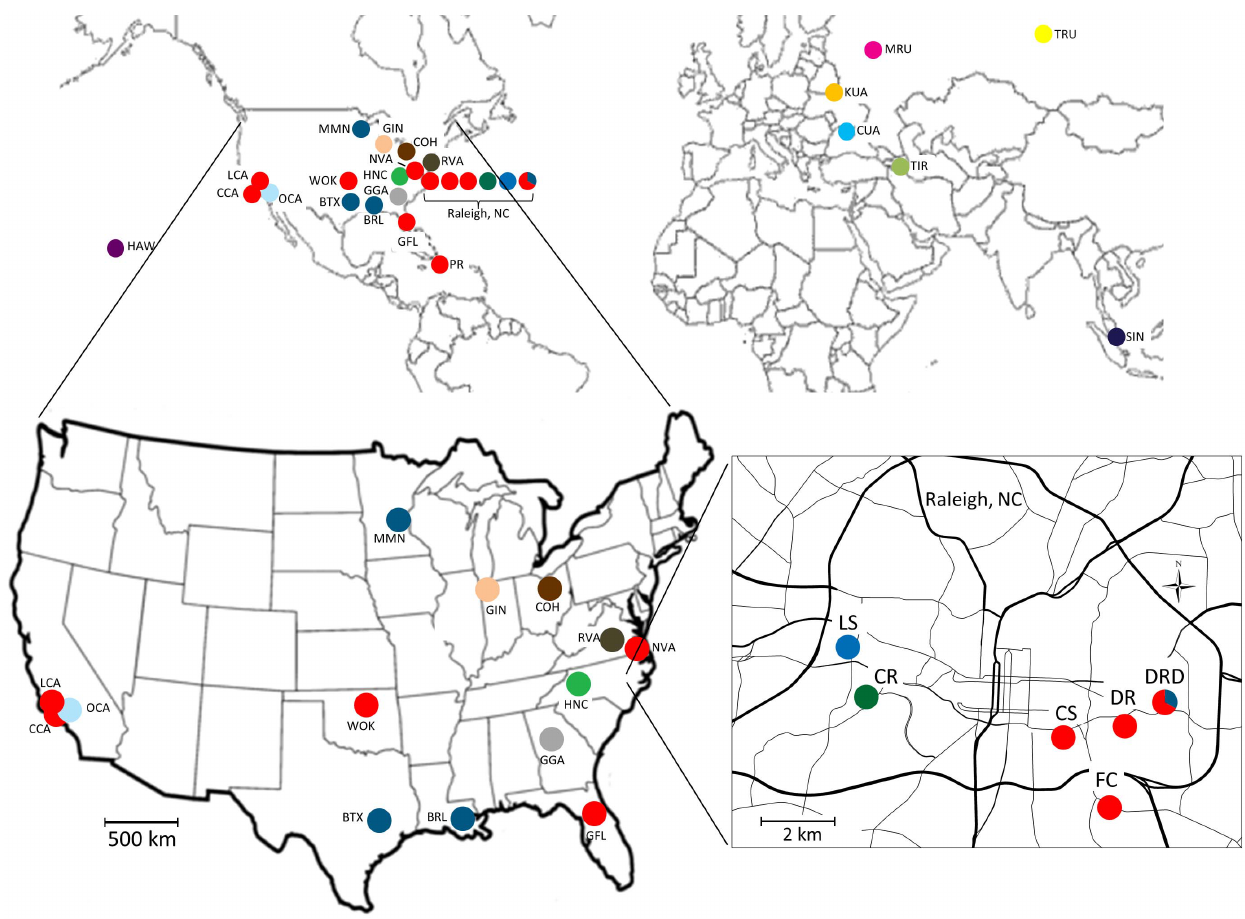
Figure 3. Bayesian cluster analysis of 40 global B.germanica populations as identified by the program BAPS. Populations given the same color were grouped into the same genetic cluster. The analysis identified 17 distinct clusters, 11 for the 36 U.S. populations, whereas each of the six Eurasian populations formed a unique cluster. The 18 Raleigh, North Carolina samples are grouped by apartment complex. In only one case (complex DRD) was an apartment not clustered together with populations from apartments in the same apartment complex. A finer resolution map showing the location of the Raleigh, NC populations is given in Crissman et al. [33].